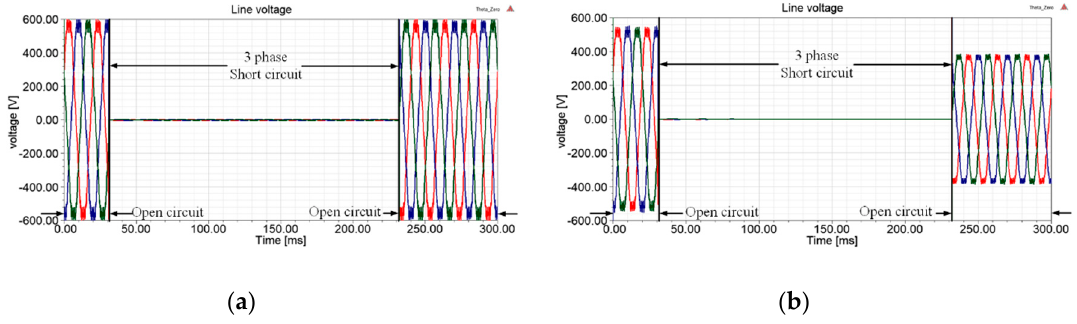
Figure 15. Back EMF before, during, and after the three-phase short circuit for ( a ) 60 °C and ( b ) 150 °C.